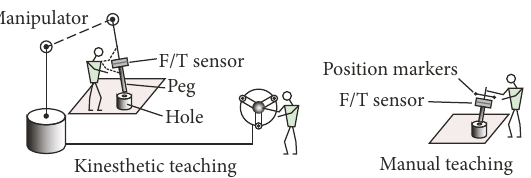
Figure 4: Different demonstration methods. Left: kinestheticteach- ing with human hands on tools or robot arms, including teleopera- tion with a remotecontrol device.Right:humandirectteachingwith recorded sensor